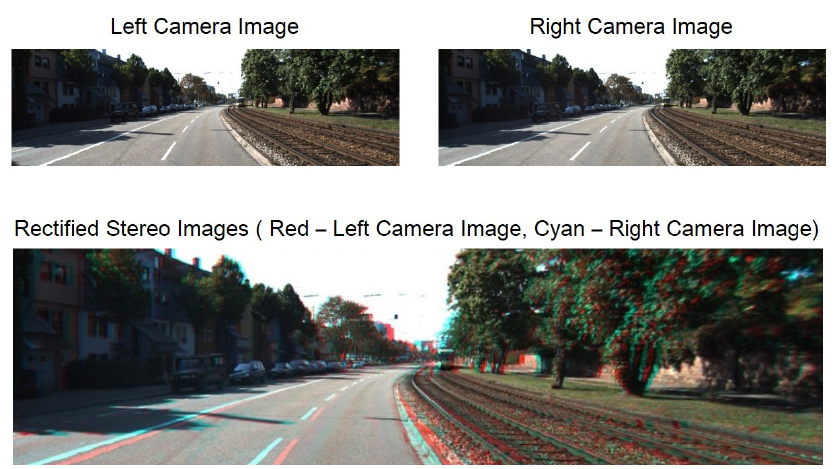
Figure 2. ( Top ) Non-rectified left and right images, and ( down ) red–cyan anaglyph from stereo pair of rectified stereo